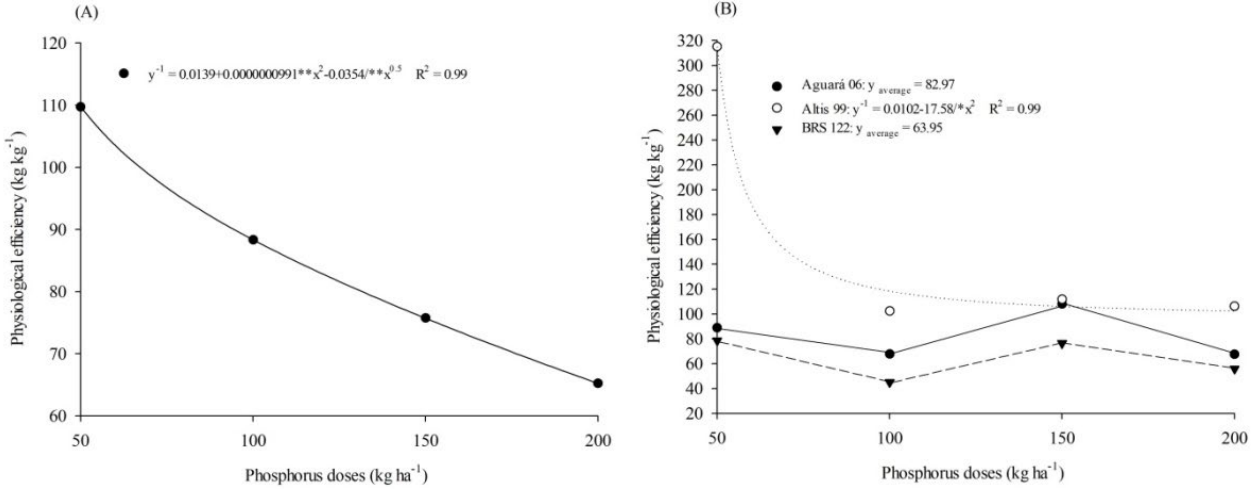
Figure 2. Physiological efficiency of sunflower as a function of phosphorus doses in the 2016 agricultural harvest ( A ) and 2017 agricultural harvest ( B ).